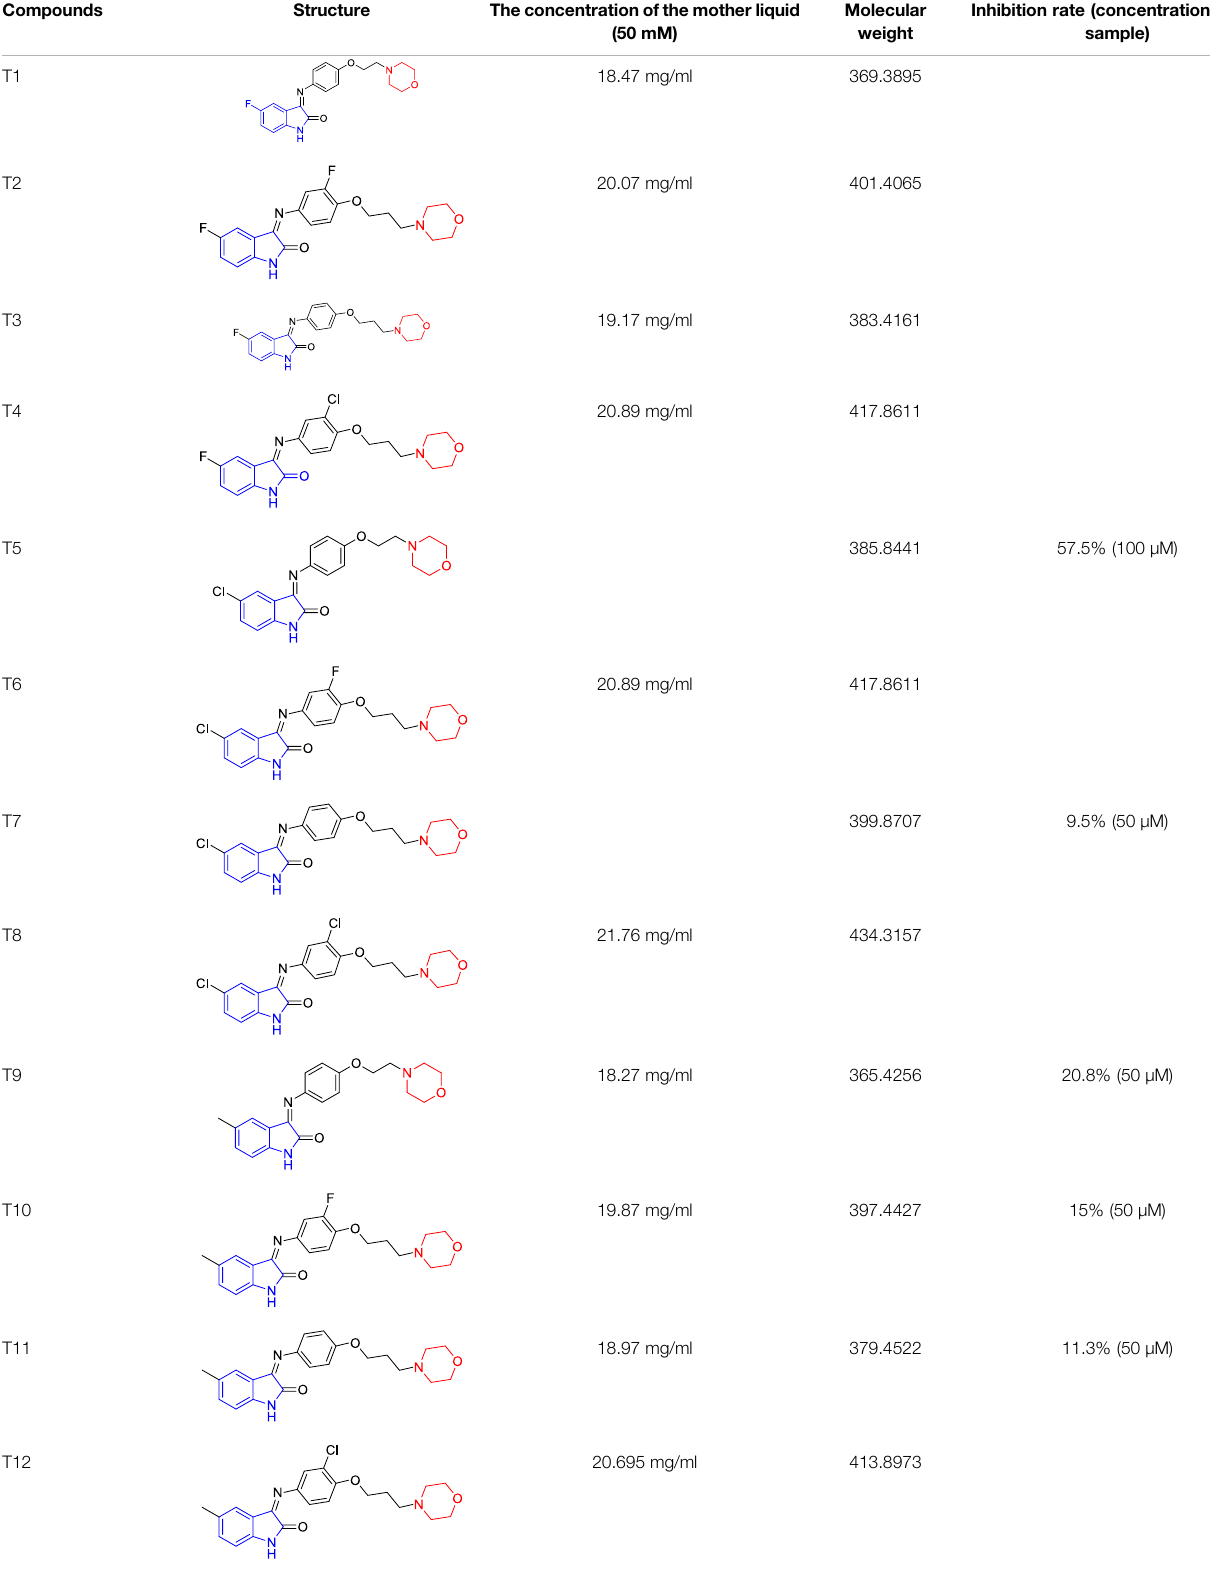
TABLE 4 | Structure and the inhibitory actions on Kv1.5 of the target compounds.